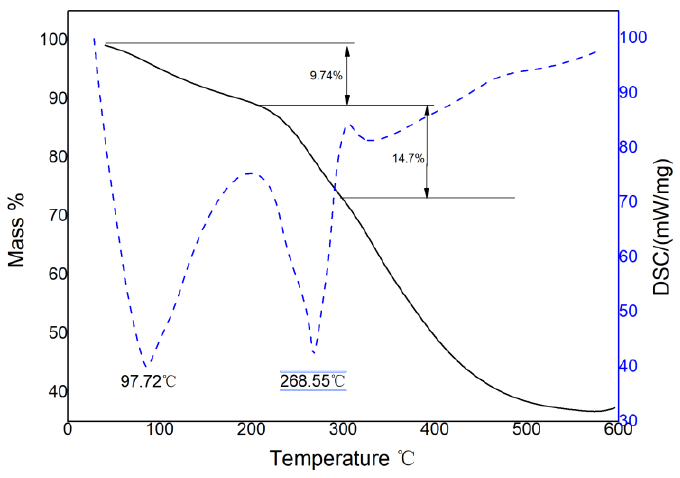
Figure 6. TG-DSC curve.